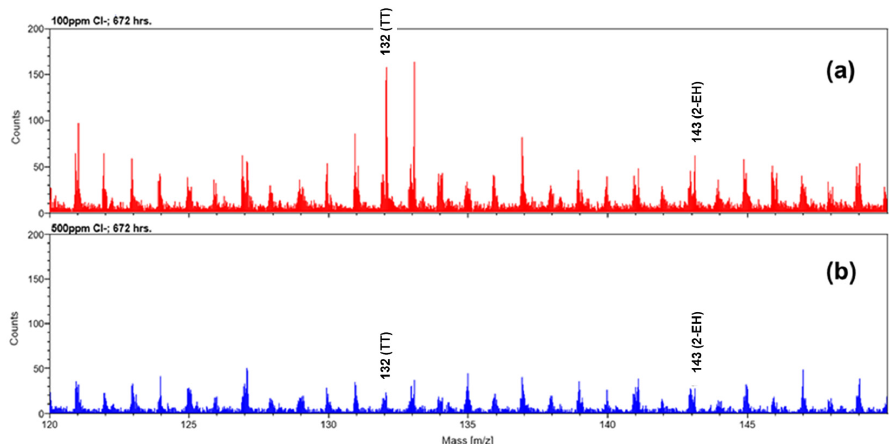
Figure 13. Negative Ion Secondary Mass Spectra Detected by TOF-SIMS for 120–150 m/z on the samples—( a ) 100 ppm chloride solution sample exposed to 28 days ( b ) 500 ppm chloride solution sample exposed to 28 days.